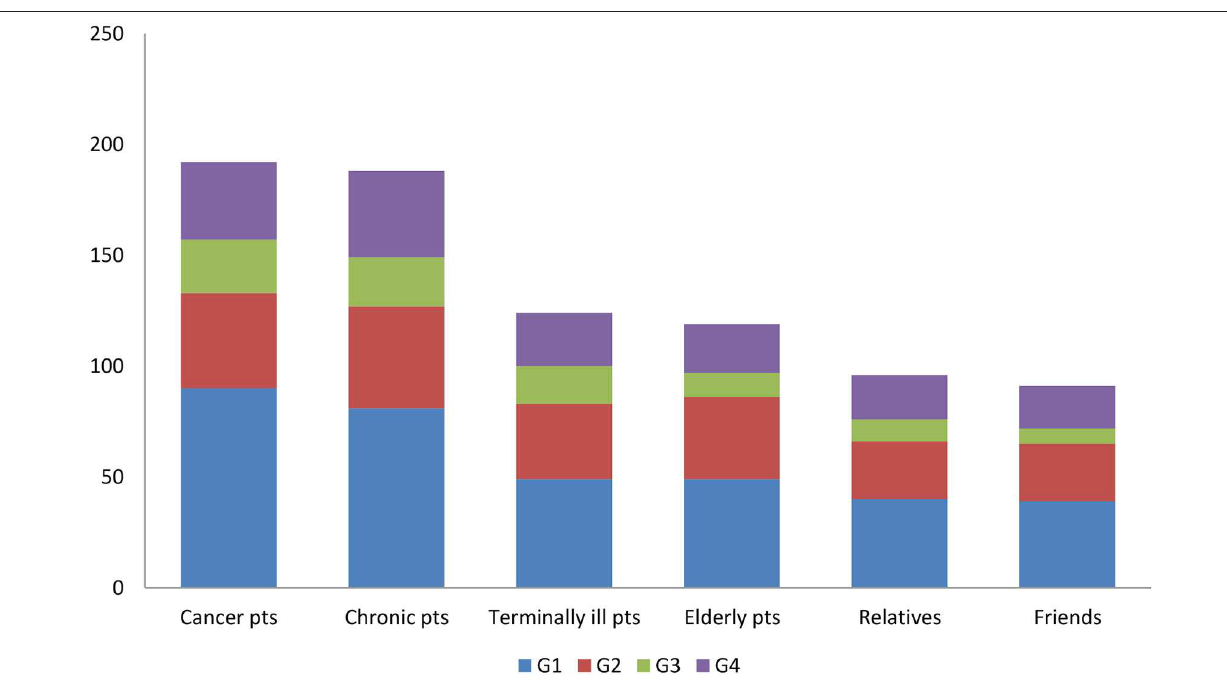
FIGURE 2 | Physicians answer to the question “To whom would you suggest using